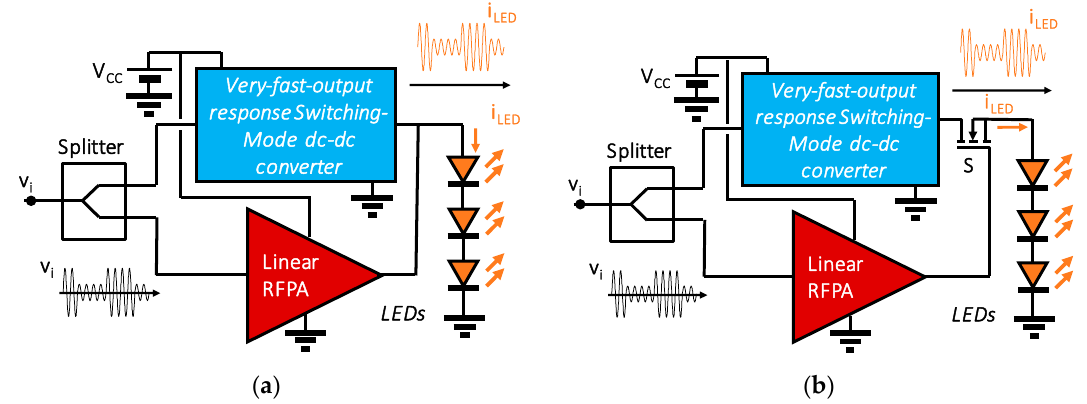
Figure 9. Linear-assisted technique applied to VLC-LED drivers. ( a ) parallel connection scheme; ( b ) series connection scheme.